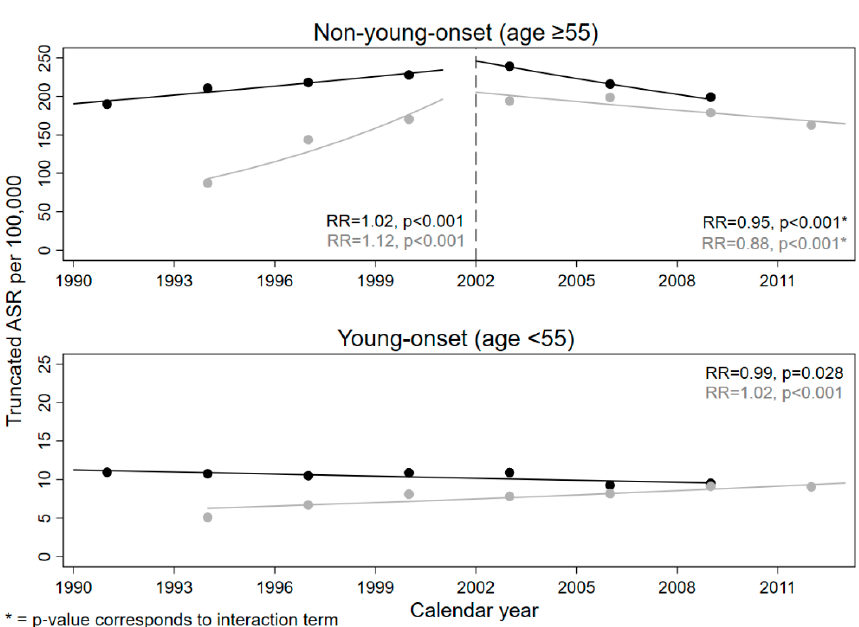
Figure 1. Observed and modeled young-onset and non-young-onset truncated ASRs of colorectal cancer incidence for the general population from 1990 to 2013; the rate ratio (RR) corresponds to the modeled calendar year effect (see Appendix A); the dashed line indicates the introduction of screening colonoscopy; black represents the Saarland population, gray the Münster population.